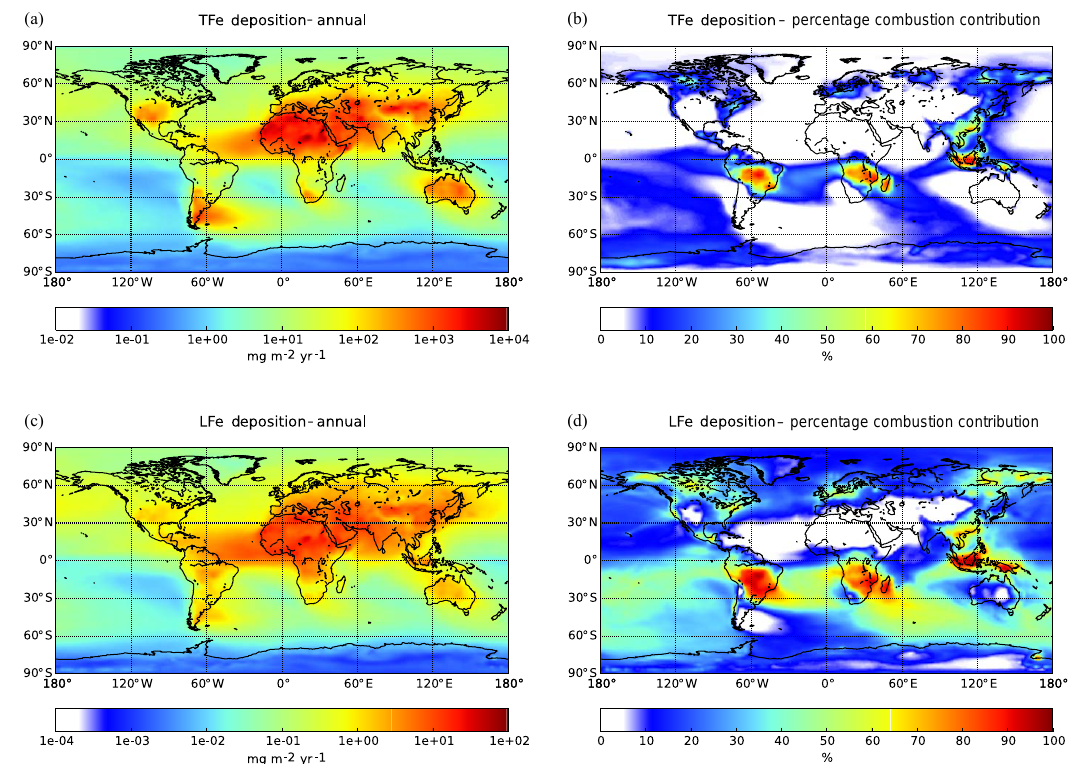
Figure 3. Ensemble model results for annual deposition fluxes (mgm − 2 yr − 1 ) for (a) TFe and for (c) LFe and their respective percentage contribution of combustion aerosols (b, d)